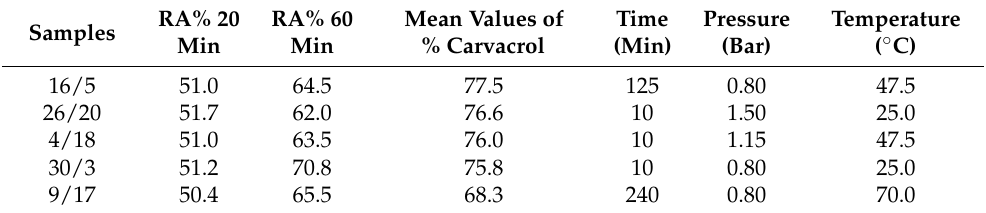
Table 6. Antioxidant activity (mean values of RA% values) in correlation with the mean % values of carvacrol content and with the distillation process factors applied.